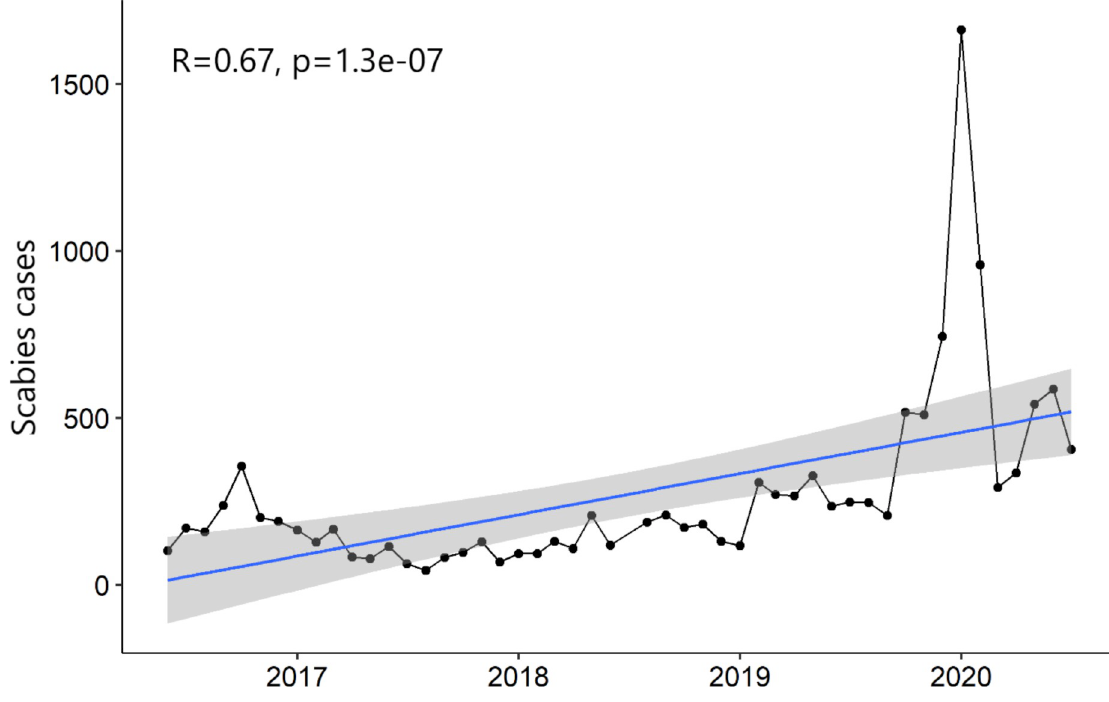
Fig 5. Trend of reported scabies cases during the time of the study period, including all data.